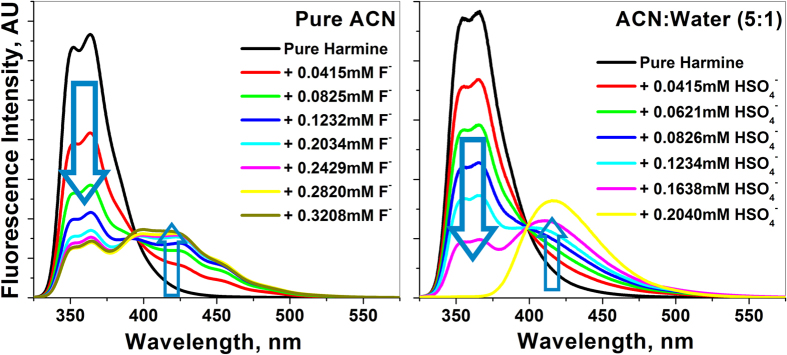
Changes in emission spectra of HM (a) in pure ACN with gradual addition of F− ions (b) in 5:1 (v/v) ACN-water with gradual addition of HSO4− ions; λexc = 300 nm; [HM] = 9.99 × 10−4 mM.